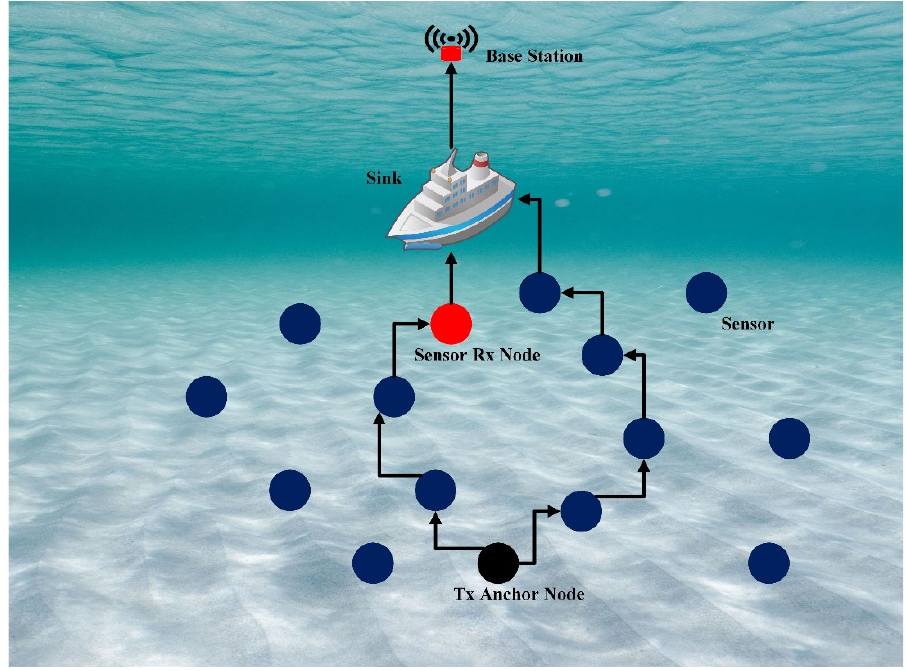
Figure 13. Cooperative reliability ‐ based E2RPs (CO ‐ RE2RPs) [146].